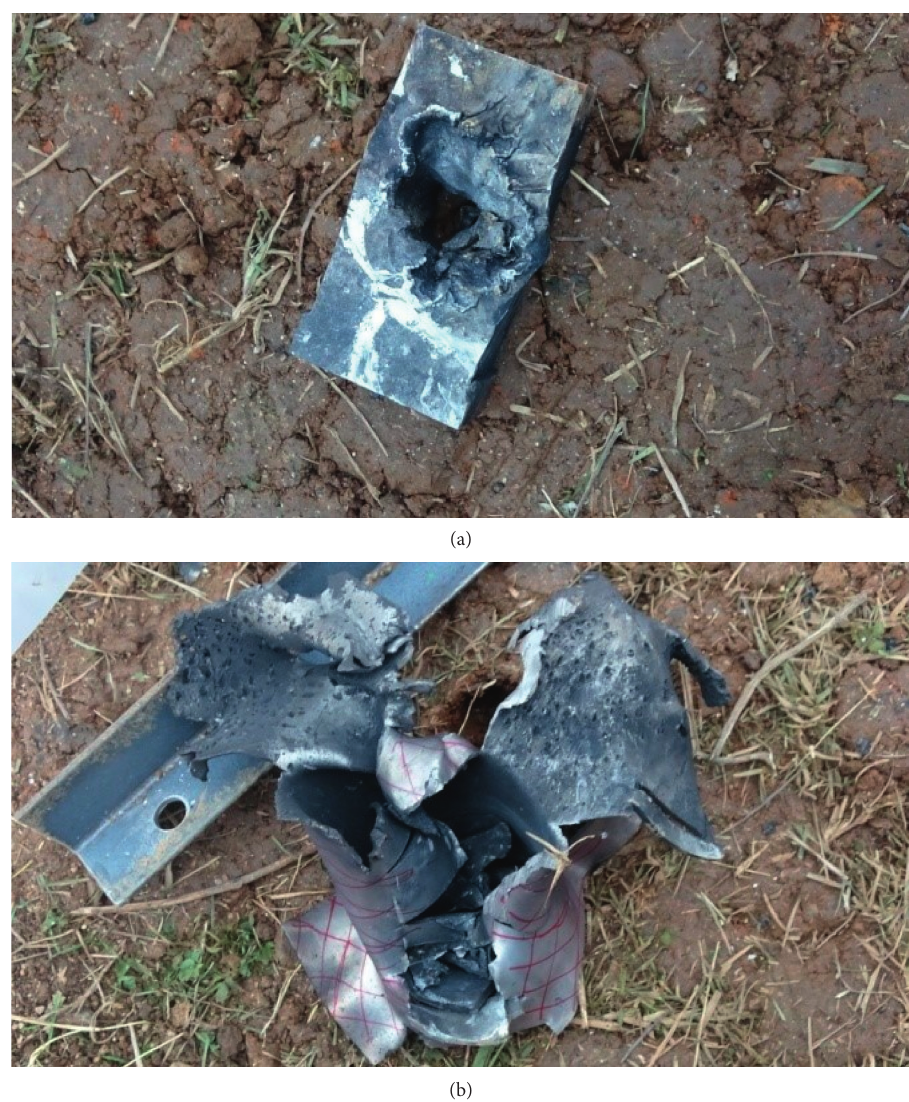
Figure 15: Wreckage of simulated guidance cabin.